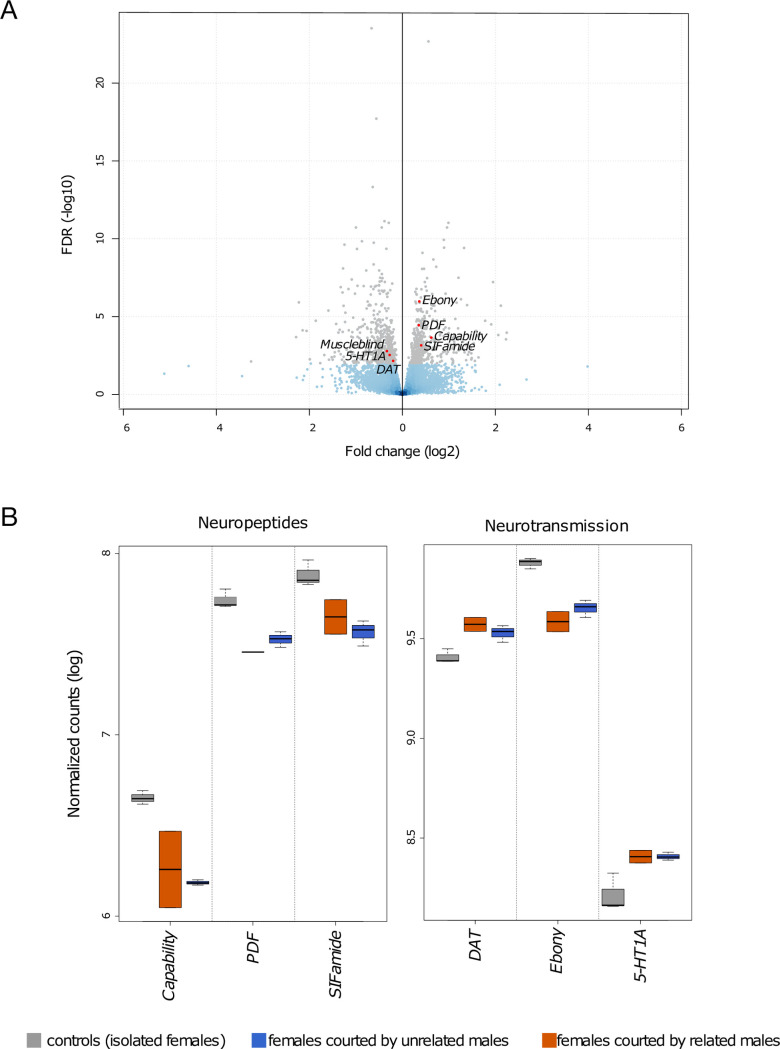
Transcriptomic response to courtship: 7.1% of the total transcriptome (grey) was regulated in response to courtship (1,001 DEGs).(A) Comparison of females courted by related and unrelated males to controls revealed 538 genes were overexpressed in courted females (negative fold change values) and 463 genes were overexpressed in isolated females (positive fold change values). (B) Boxplot showing significant expression changes following courtship in highlighted genes mentioned in the text. The X axes indicate gene names, the Y axes show normalized counts after log transformation, and the boxplot whiskers show the range of read counts between biological replicates. PDF, pigment-dispersing factor; DAT, Dopamine transporter; 5-HT1A, Serotonin transporter 1A.